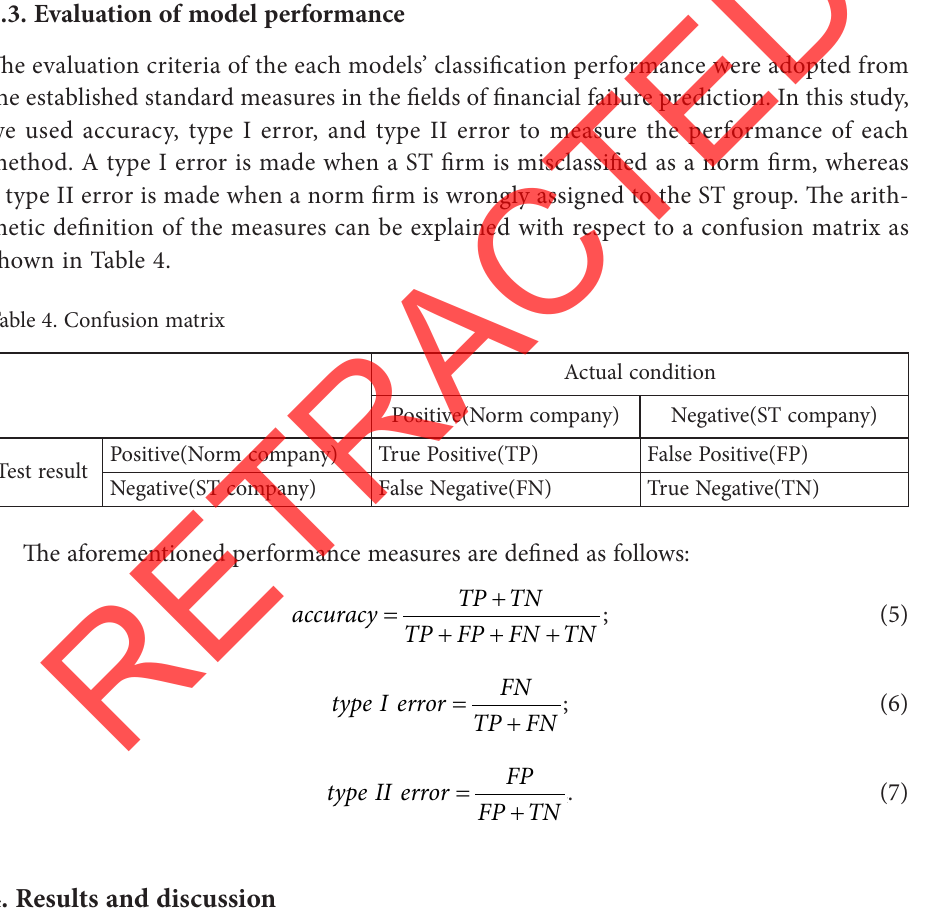
Table 4. Confusion